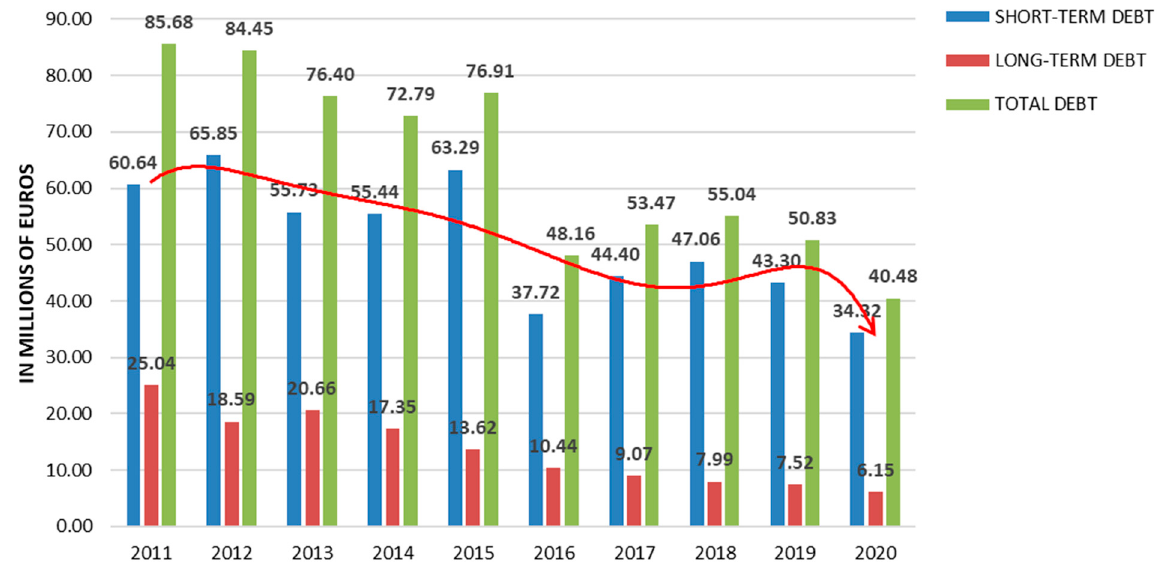
Figure 2. Decrease in the debt of Spanish sport federations in the period 2011–2020. Source: CSD. Subdirección General de Deporte Profesional y Control financiero (2021). The great economic figures of the Spanish NSFs 2011–2020 [47].